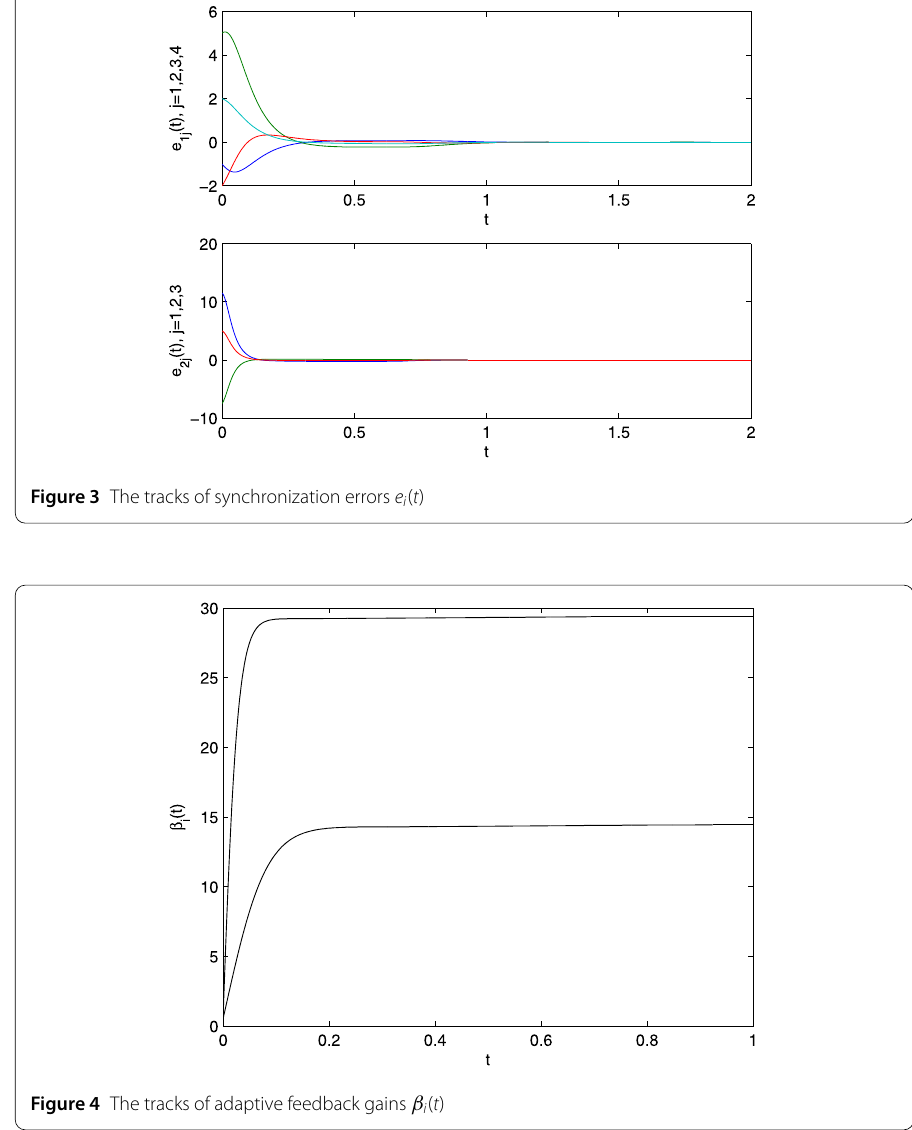
In order to obtain the FMPS in which the internal time delays are different from the cou- pled delays, the hybrid feedback controller is given, by utilizing Lyapunov stability theory and mathematical induction. The coupling matrices are not required to satisfy the sym- metry and the diffusion conditions. Finally, through presenting a numerical simulation we display the validity and appropriateness of our given